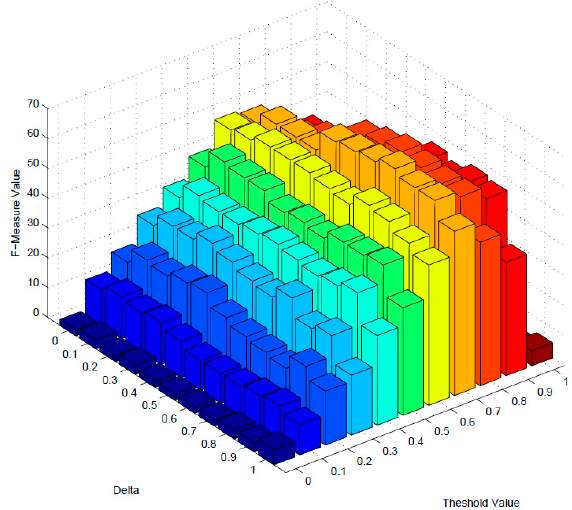
Figure 5. The F-measure of multi-dimension.